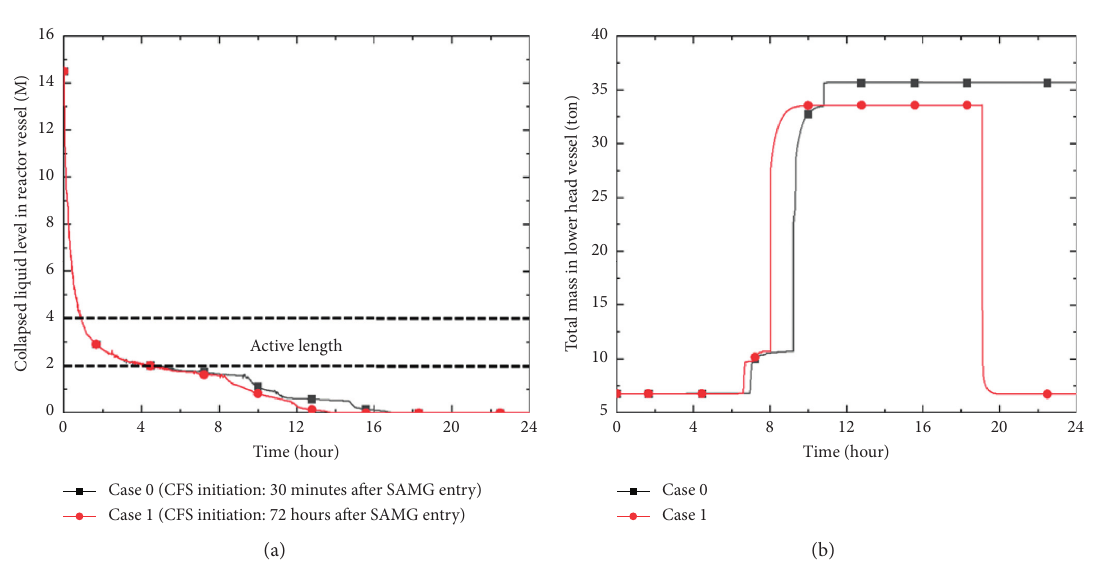
Figure 4: (a) Collapsed liquid level in the reactor vessel and (b) total mass in the lower head